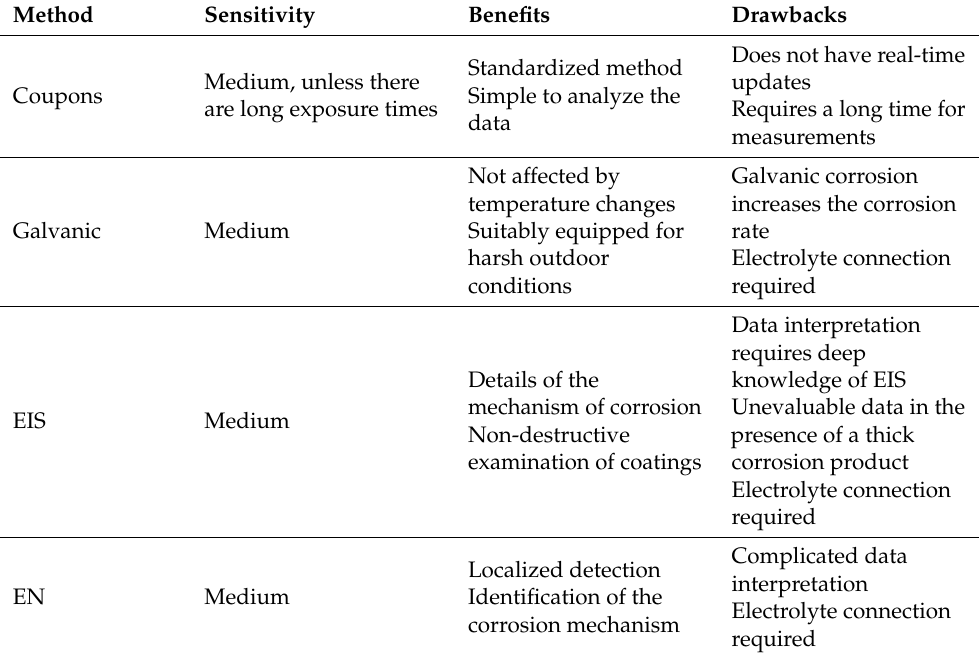
Table 1. Comparison of atmospheric corrosion